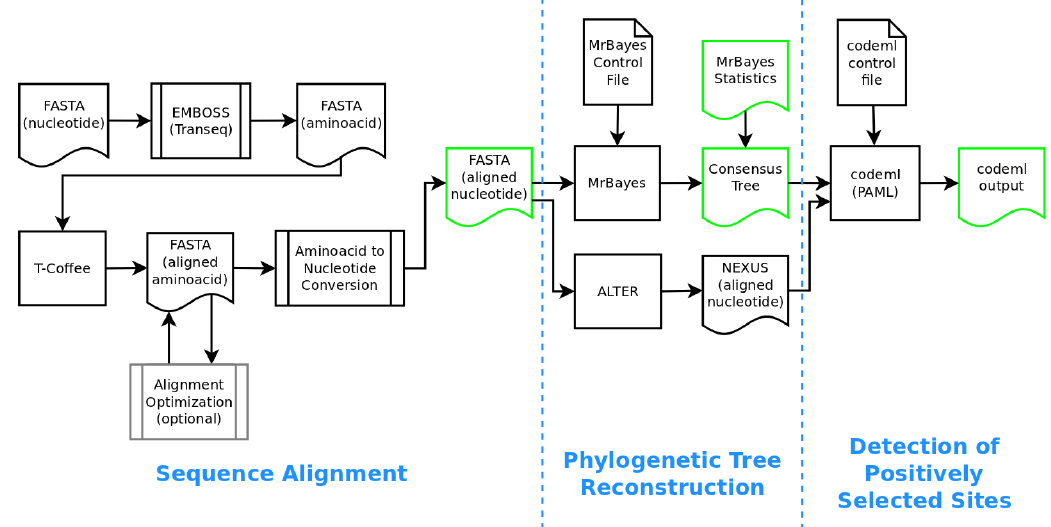
Figure 1: Schematic ADOPS